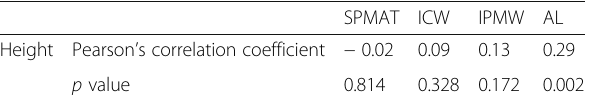
Table 1 Correlation of height with different odontometric variables